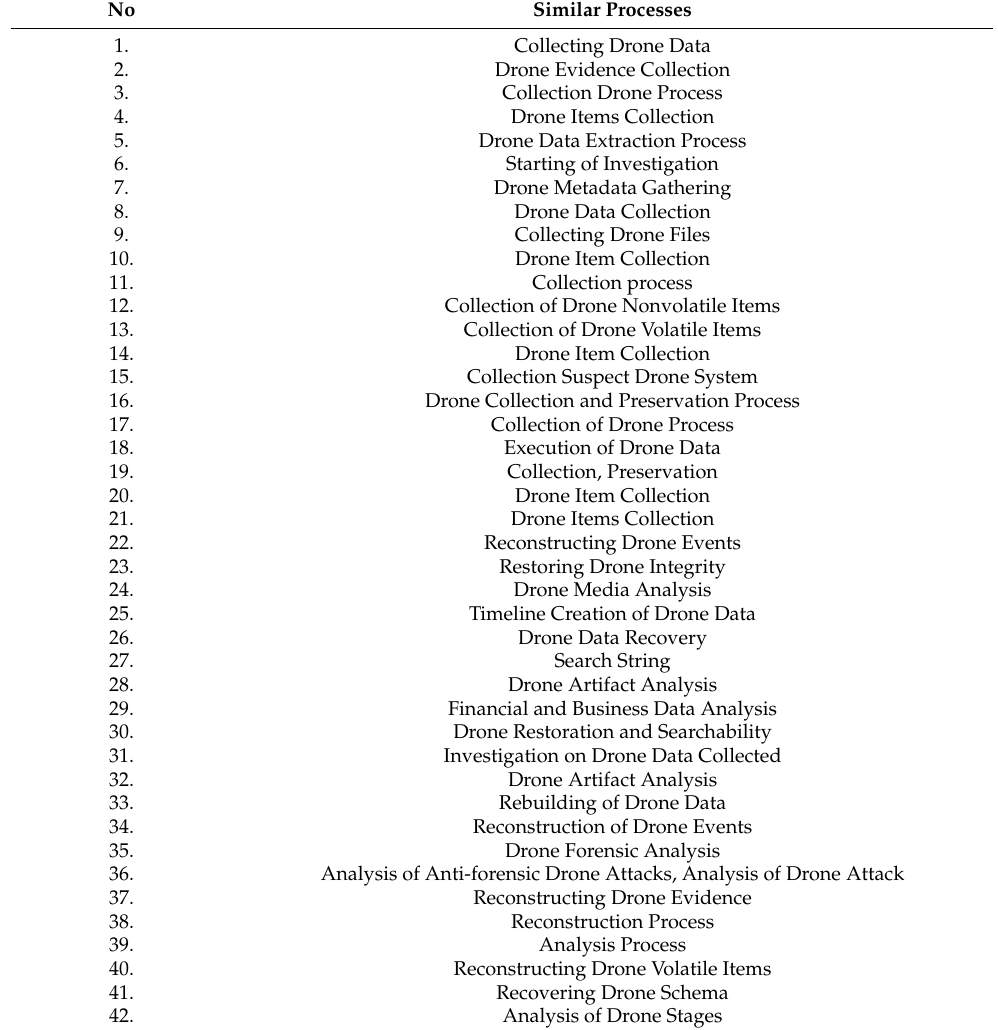
Table 2. Extracted